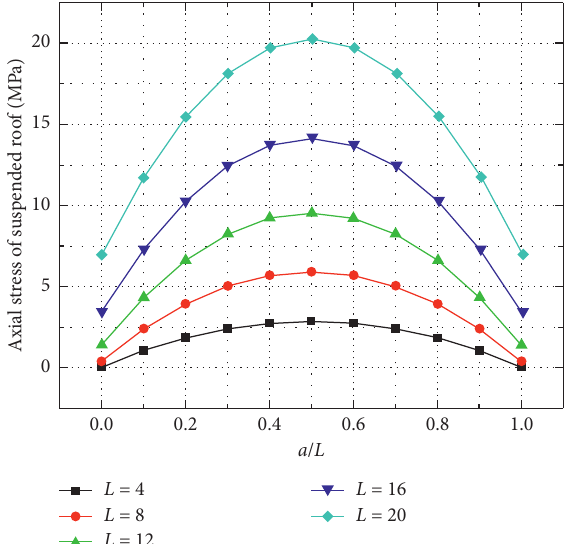
Figure 10: Axial stress of the residual coal pillar with “ a / L.